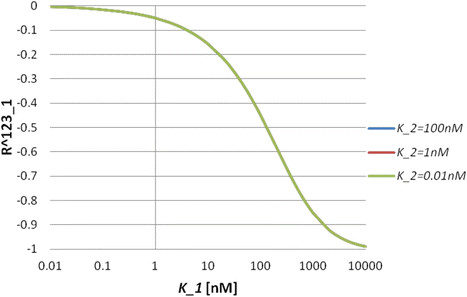
Behaviour of the response coefficient for Model SB3. Response coefficient R1123 as a function of K1 for K2 = 100nM, 1nM and 0.01nM. Here, we set K3 = 100nM